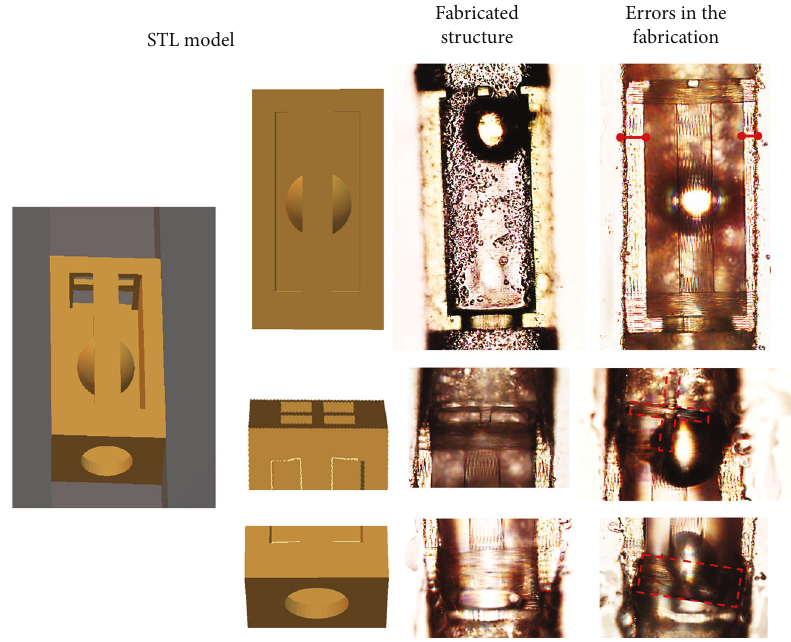
Figure 5: On the right - STL model and structures manufactured within the micrometric channels. In the center is an ideal structure. On the right are the possible manufacturing